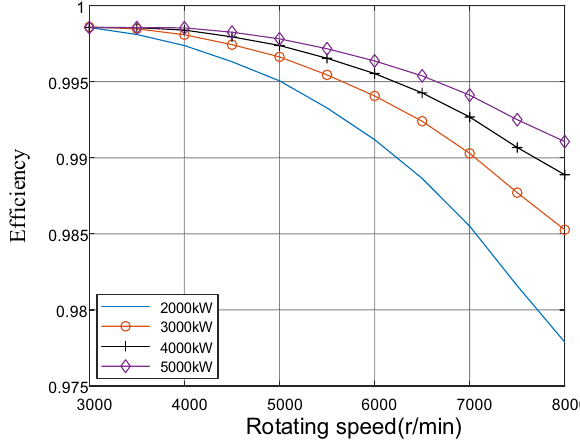
Fig. 4 Efficiency at different speed with constant torque